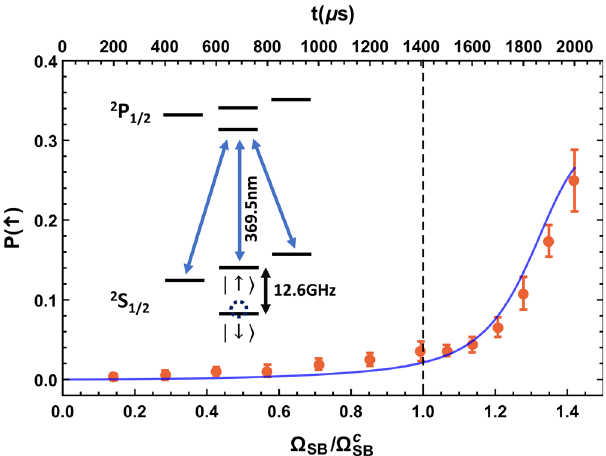
Fig. 2 Spin-up state population versus sideband Rabi frequency. By setting δ b = 2 π × 52.0 kHz and δ r = 2 π × 48.0 kHz, we keep the ratio parameter R = ω a / ω f = 25 fi xed. As we increase the sideband Rabi frequency Ω SB (bottom axis) linearly with time (top axis), i.e., Ω = τ Ω ¼ 2 π ´ 14 : 2 kHz and the quench time τ Ω max t q where max two pre-determined parameters, the control parameter g ð t Þ ¼ q ffiffiffiffiffiffiffiffiffiffiffiffiffiffiffi δ 2 (cid:3) δ 2 goes up accordingly. With a duration time t , we 2 Ω SB ð t Þ = b r prepare a target state under g ( t ) and measure the spin-up state population by fl orescence detection. Every orange dot is the average of 20 rounds of measurements of the spin-up state population, corrected by subtracting the 1.0% dark-state detection error as the background; the error bar is estimated as one standard deviation of the 20-round outcomes (see Supplementary Information for more details about the error bar estimation). For each round of measurement, we repeat the experiment sequence for 500 shots and take the average. The blue curve is the theoretical value by directly solving the time-dependent Schrödinger equation under the QRM Hamiltonian. The vertical dashed line is an indication of the quantum critical point g c = 1 (corresponding ¼ 2 π ´ 10 kHz). The inset shows the fl orescence detection to Ω c SB scheme of 171 Yb + ions 46